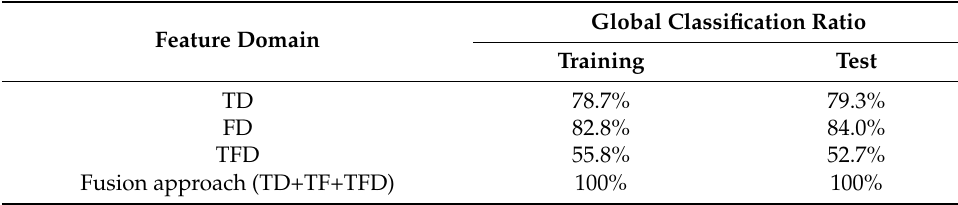
Table 6. Resulting feature selection achieved by the GA–PCA selection structure applied to each evaluated condition for each analyzed